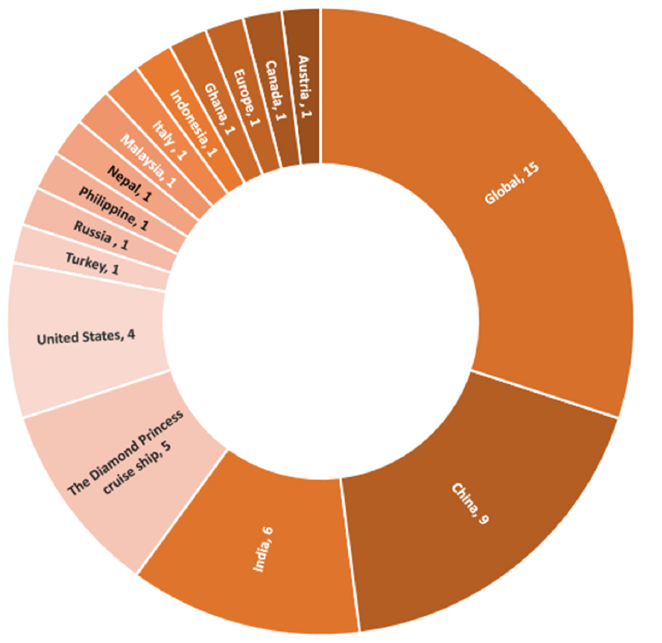
Figure 4. Geographic location among recorded papers.